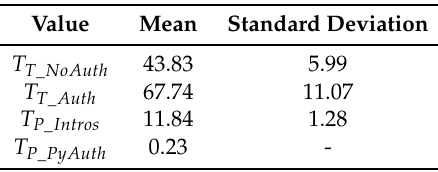
Table 2. Results in delay measurement (milliseconds). T T _ NoAuth : Time without using the authorization